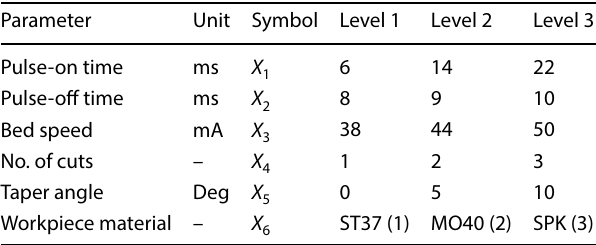
Table 6 Input parameters and their levels